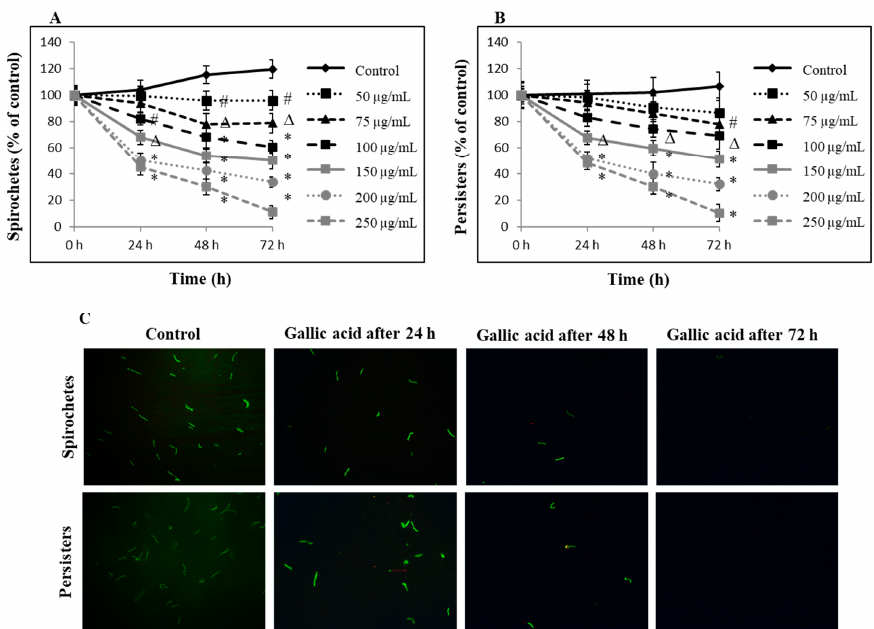
Figure 1. Kinetic evaluation of biocidal effect of gallic acid. Dose-dependent efficacy of gallic acid against spirochetes and persisters of B. burgdorferi B31 was monitored up to 72 h and determined by SYBER Green I/IP assay using spectrofluorescent measurement ( A , B ). Representative images of live/dead images of spirochetes and persisters of B. burgdorferi B31 stained with SYBER Green I/IP day ( C ). Images taken at 200× magnification; # p ≤ 0.05, ∆ p ≤ 0.01, * p ≤ 0.001; control—DMSO only (0.125%).